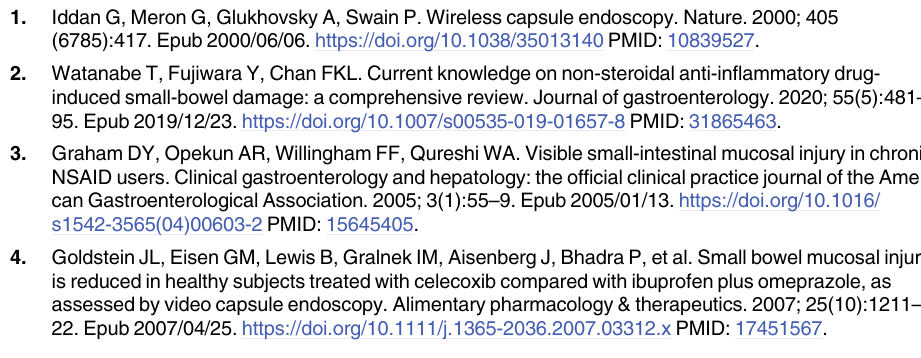
S3 Table. The major bacterial composition of small intestine in mice given rebamipide or vehicle at species level. S4 Table. The major bacterial composition of small intestine in microbiota-transplanted mice administered with omeprazole at phylum level. S5 Table. The major bacterial composition of small intestine in microbiota-transplanted mice administered with omeprazole at genus level. S6 Table. The major bacterial composition of small intestine in microbiota-transplanted mice administered with omeprazole at species